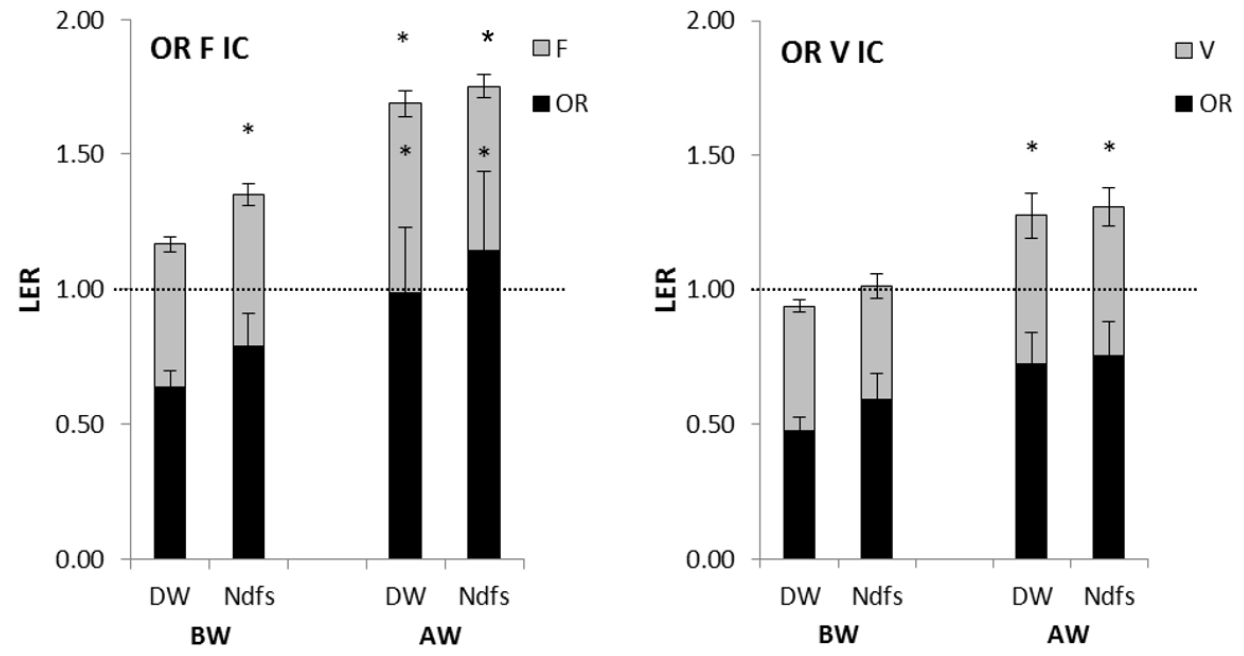
Figure 3. Total and partial Land Equivalent Ratio (LER) of oilseed rape (OR), faba bean (F) and common vetch (V) using aboveground biomass (DW) and soil N uptake (Ndfs) before winter (BW) in December and after winter (AW) in February when oilseed rape is intercropped using a replacement design with faba bean (OR F IC) or common vetch (OR V IC). Values are mean ( n = 8) ± standard error for the two experimental years 2013/14 and 2015/16. “*” above the histogram indicates that a total LER was significantly higher than 1 at p = 0.05, whereas “*” on the histogram indicates that a partial LER was significantly higher than 0.5 at p = 0.05.